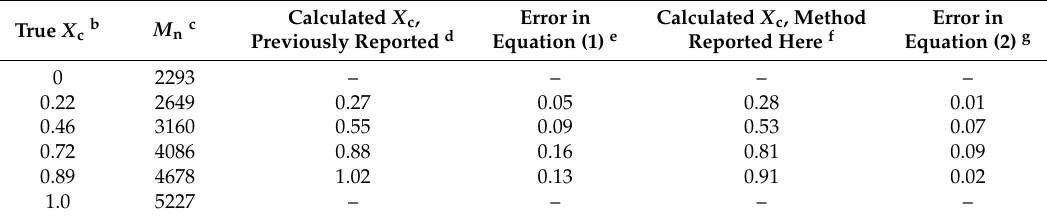
Table 1. Percent “Coupling” Calculations of Mixed PS Standards 2500:5000 a .